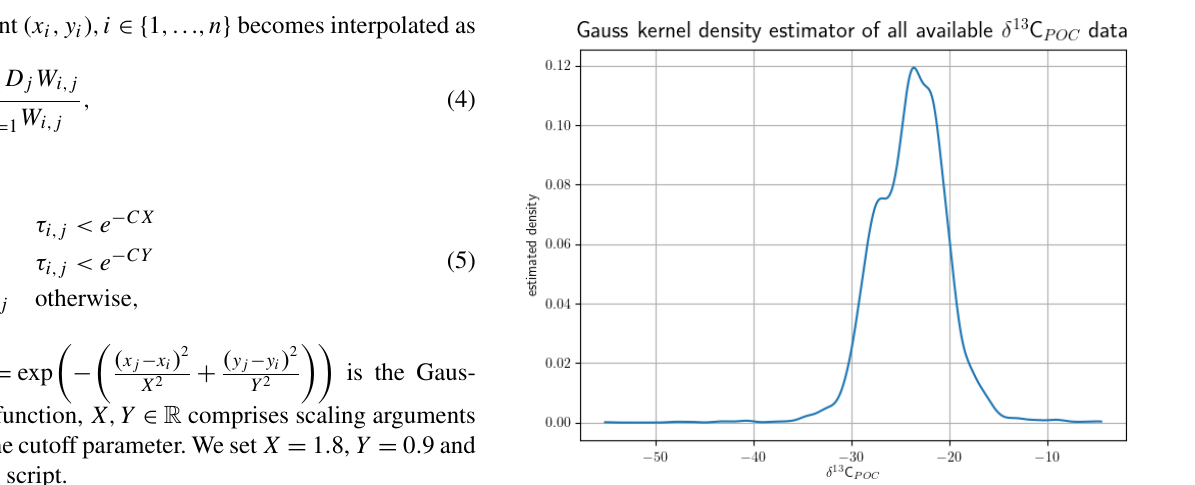
Figure 1. The density function of all individual δ 13 C POC measure- ments approximated by Gaussian kernel density estimation: values of the estimated density are drawn on the y axis; the δ 13 C POC val- ues run on the x axis. The higher the value of the estimated density is, the more δ 13 C POC points have been measured around this